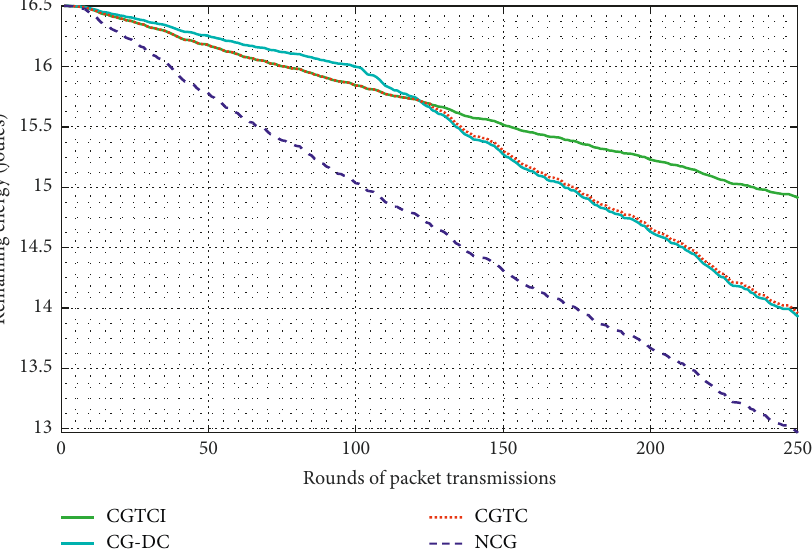
Figure 10: Trend of the remaining energy for the devices located farthest from the BS.